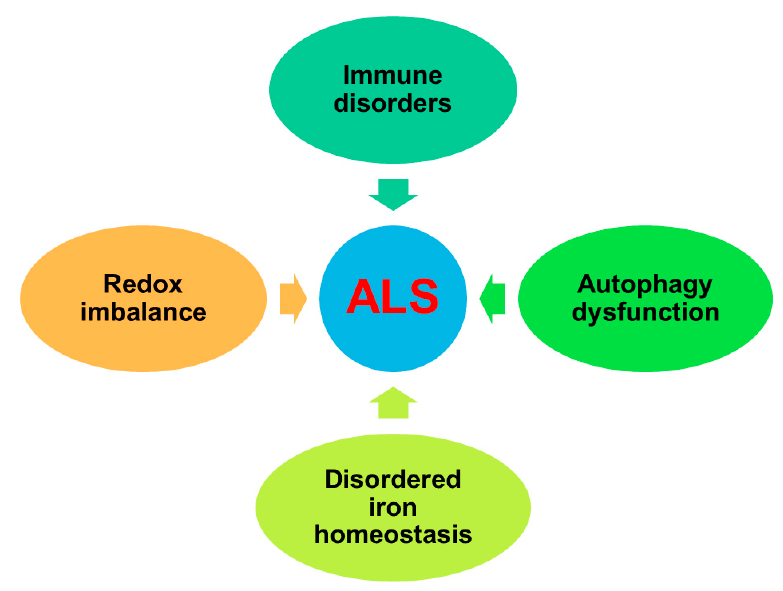
Figure 1. Pattern diagram of pathogenic factors in ALS.